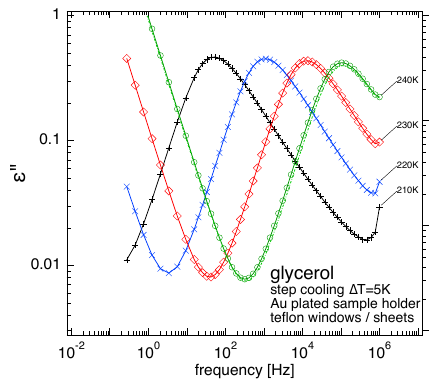
Figure 2. Frequency dependence of the imaginary permittivity of a glycerol sample, measured in a gold coated flat sample holder, placed in an IN16B cryofurnace, suited for simultaneous neutron scattering.